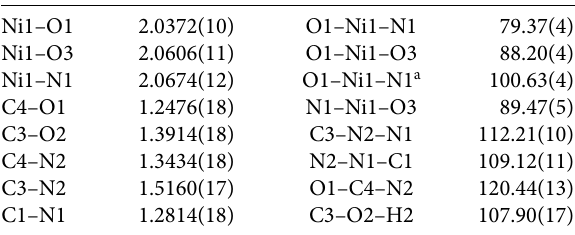
Table 2. Selected bond lengths (Å) and angles (°) in the Ni(II) com- plex